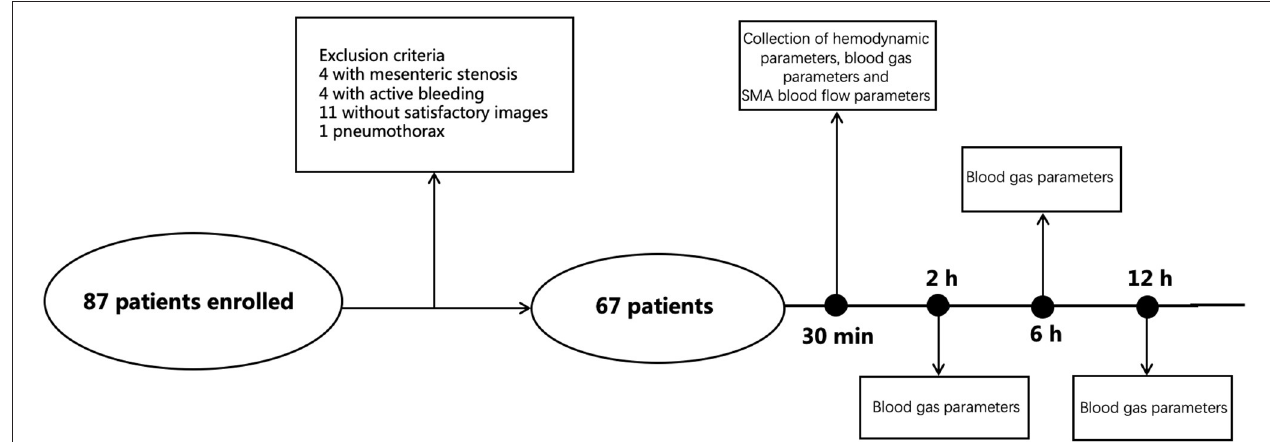
FIGURE 1 | Enrolment flowchart of the study